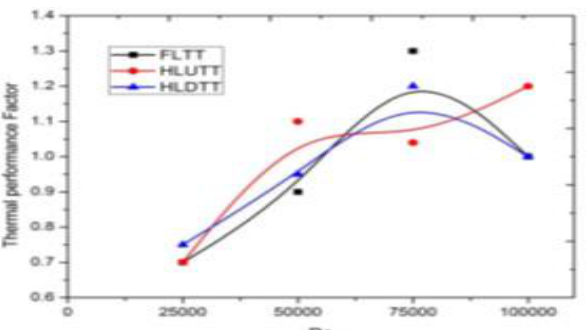
Figure 4: Variation of Re with thermal performance factor for a twist ratio of 0.14 with Q=2300 W/m 2 [12].